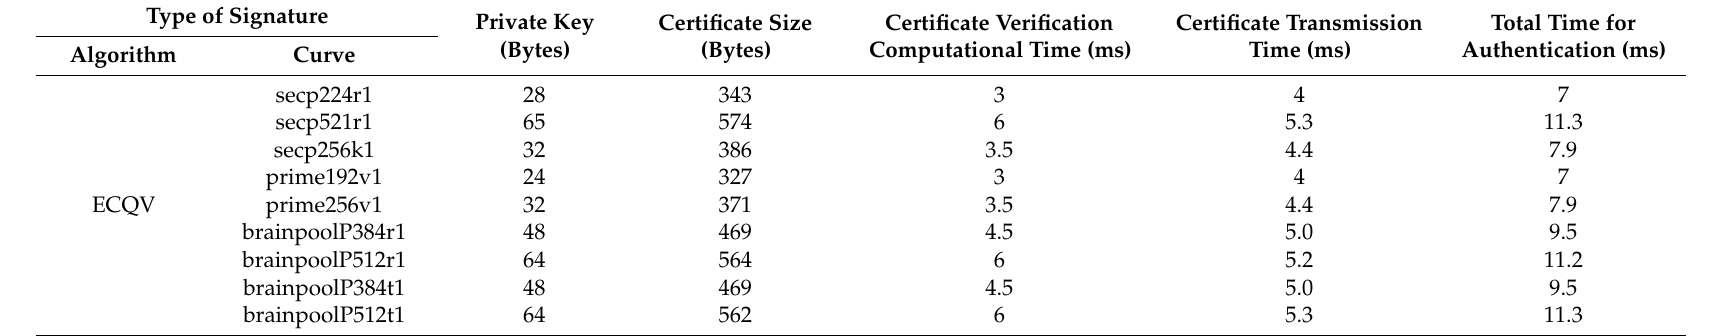
Table 3. Computational times for ECQV implicit certificate verification for